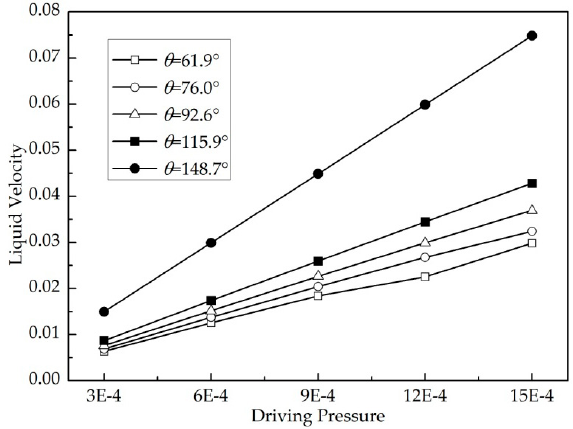
Figure 10. Liquid velocity against driving pressure.